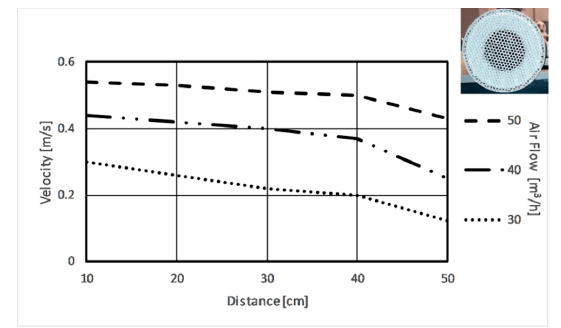
Figure 7. Mean air velocities in the case of TSP 100 type ATD.